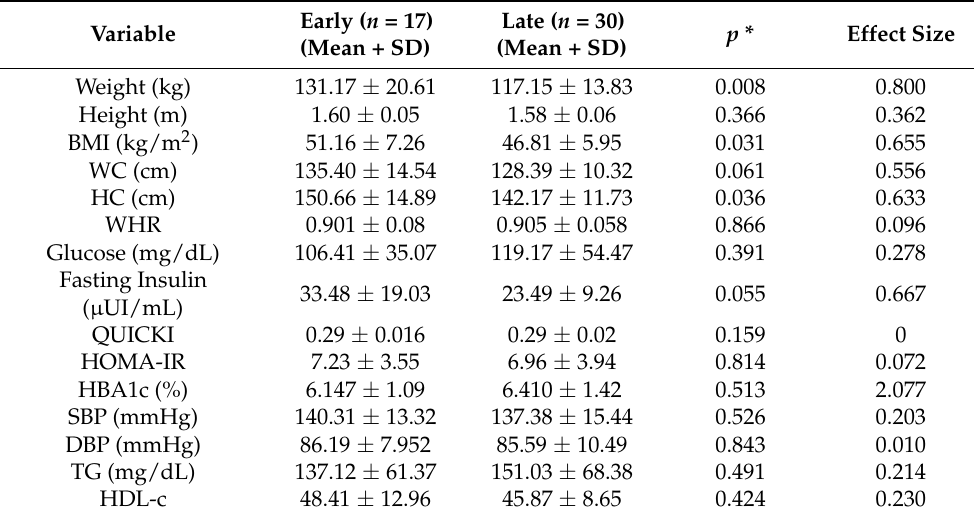
Table 2. Association of the life stage at obesity onset with anthropometric and metabolic parameters and metabolic syndrome